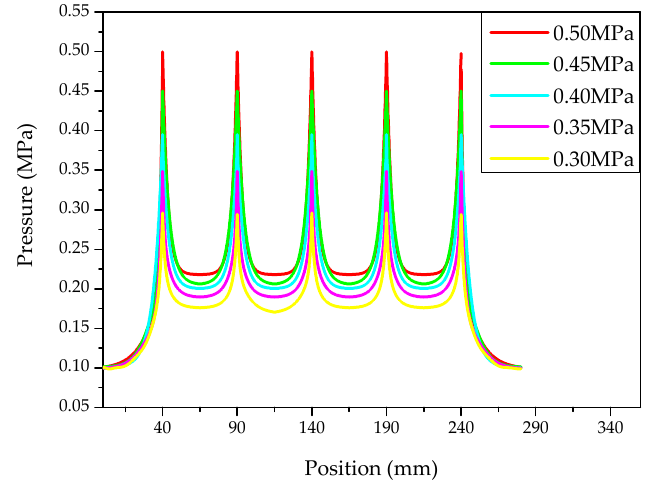
Figure 11. Effect of the supply pressure on the surface pressure of an air film in a balanced state.